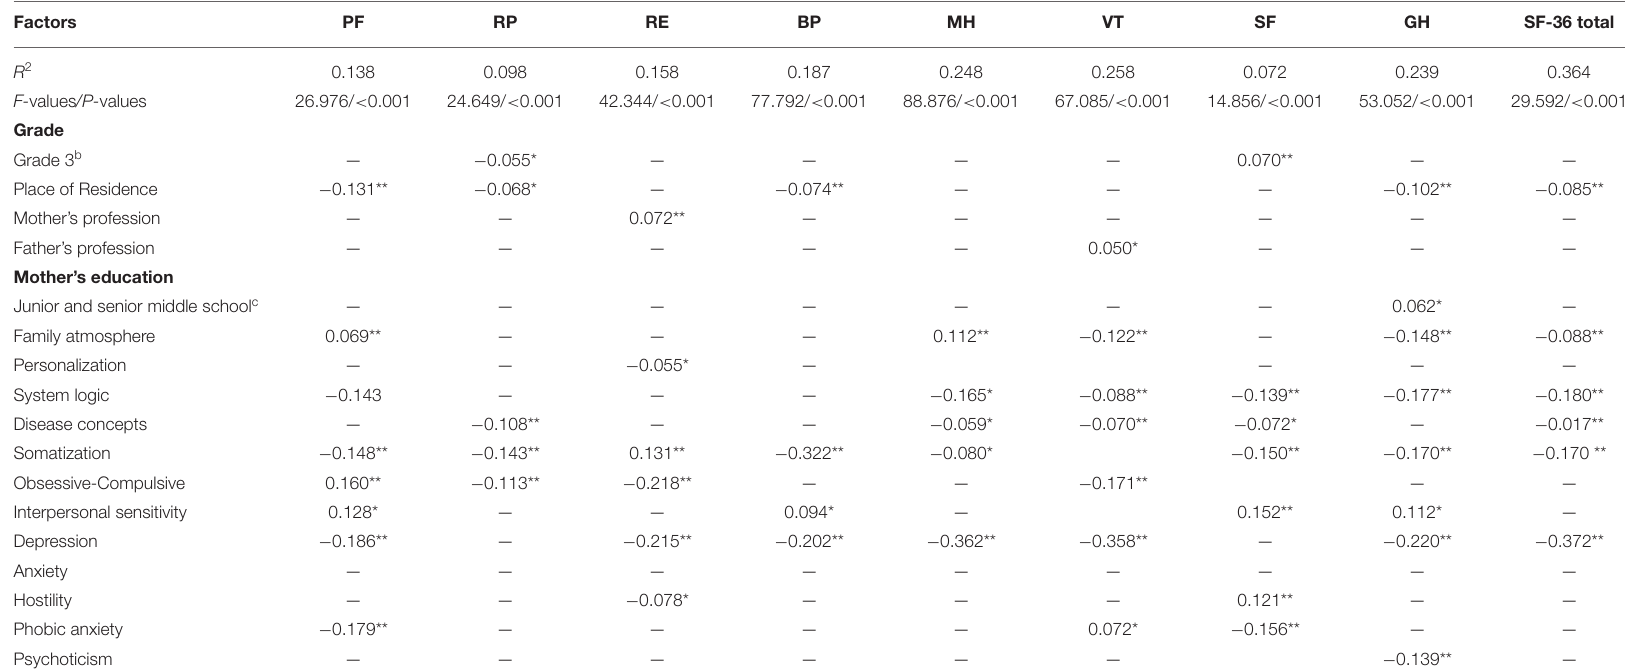
TABLE 6 | Multiple linear regression analysis of demographic, SSFD, and SCL-90-R parameters by SF-36 subscales a .